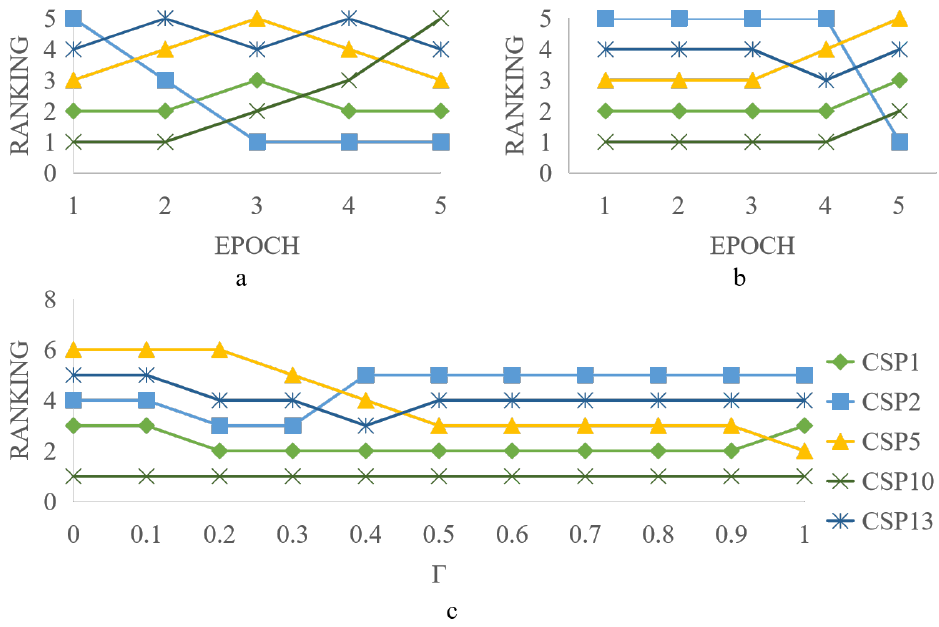
Figure 5. Changes in global value ordering under different parameter adjustments. ( a ) QoS parame- ters. ( b ) User requirements. ( c ) Subjective weight coefficient γ